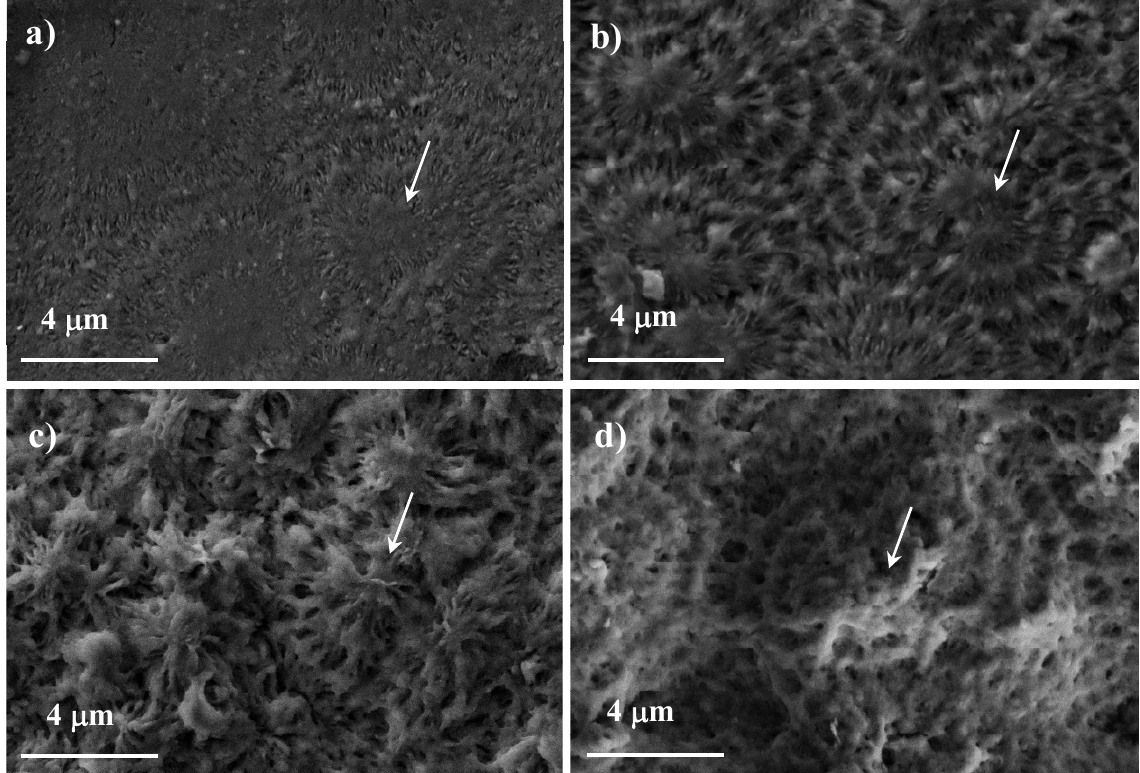
Figure 11. Scanning electron micrographs of a poly(butylene azelate- co -butylene succinate) sample after exposure to the lipase medium at 25 °C for 3 ( a ); 7 ( b ); 14 ( c ) and 21 days ( d ). White arrows point out spherulitic morphologies that are progressively